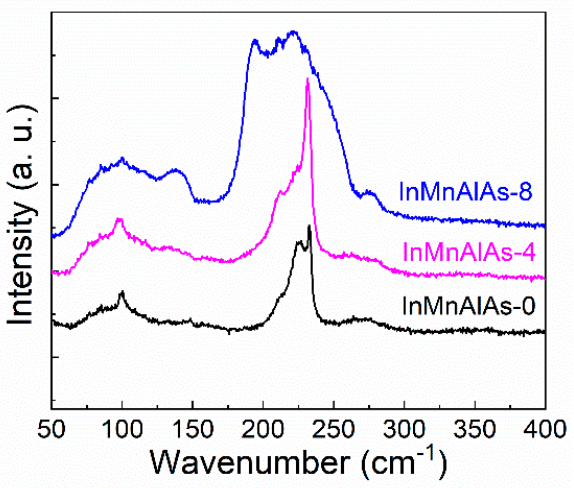
Figure 2. Raman spectra of samples InMnAlAs-0 (black); InMnAlAs-4 pink); InMnAlAs-8 (blue).